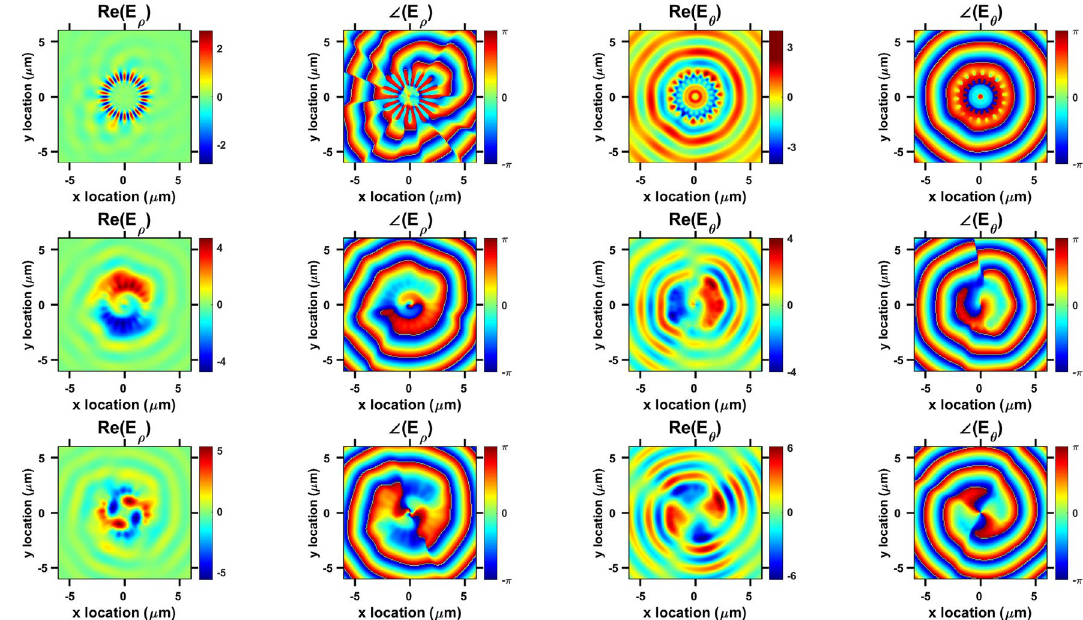
Figure 2. Finite-difference time-domain (FDTD) simulations of in-plane electric field components E ρ and E θ captured at 0.5 µ m above the m = 18 micro-gear surface. First, second and third rows plot the fields for TE 18,1 (at 1792 nm), TE 19,1 (at 1727 nm), and TE 20,1 (at 1670 nm), respectively. Real values of the electric field components and the corresponding phase plots indicate OAM order of 0, 1, and 2,